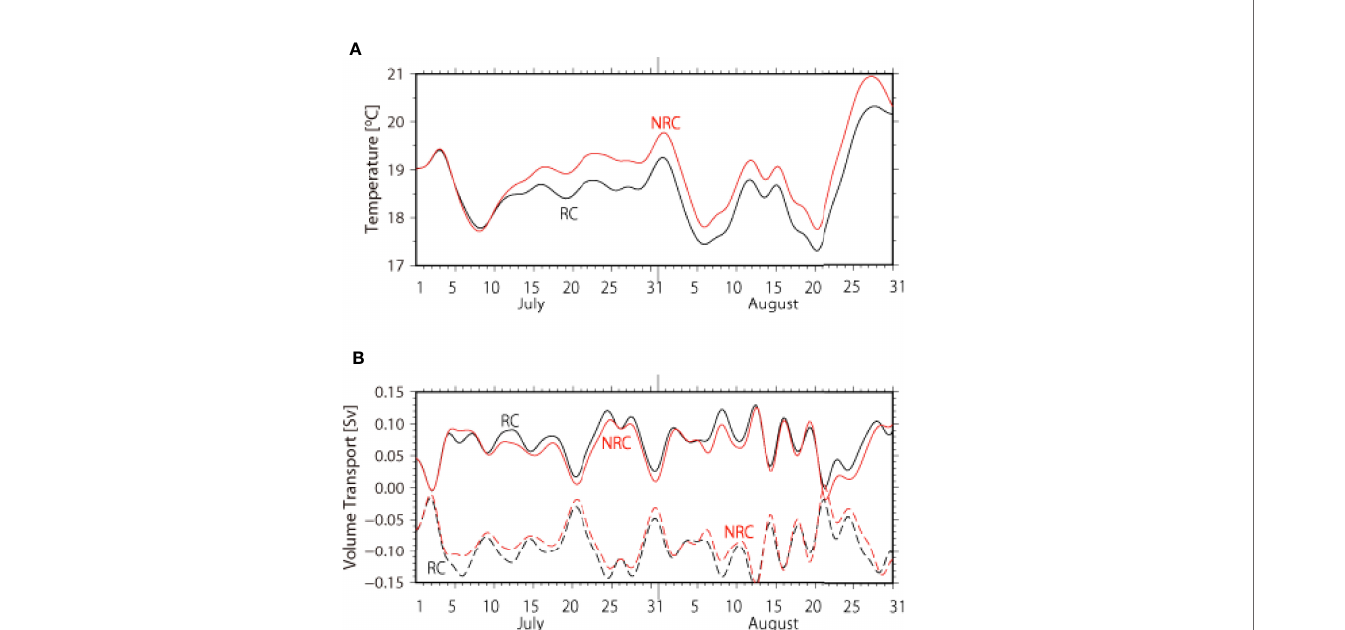
FIGURE 10 | Temporal variation in the (A) calculated water temperature below 50 m depth averaged in the control volume shown in Figure 1B as a black square, and (B) calculated volume transports above 50 m depth and below 50 m depth across 32.92°N. Black and red lines show the variation in the rain (RC) and no-rain (NRC) cases, respectively.